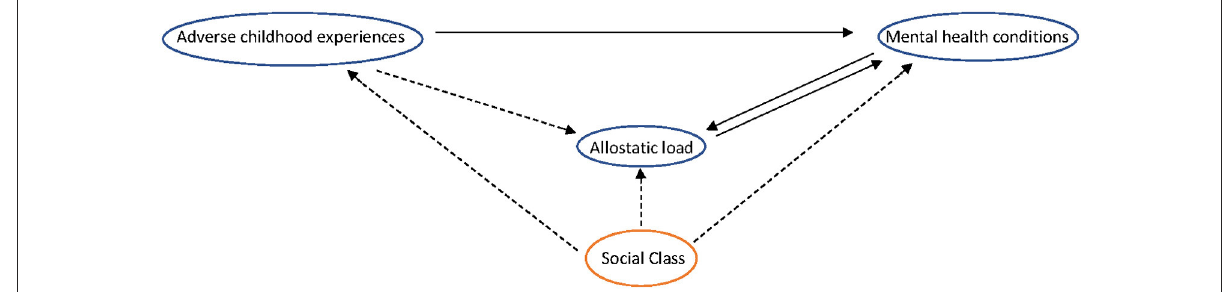
FIGURE2 A conceptual model of the association between adverse childhood experiences, allostatic load, and mental health conditions.